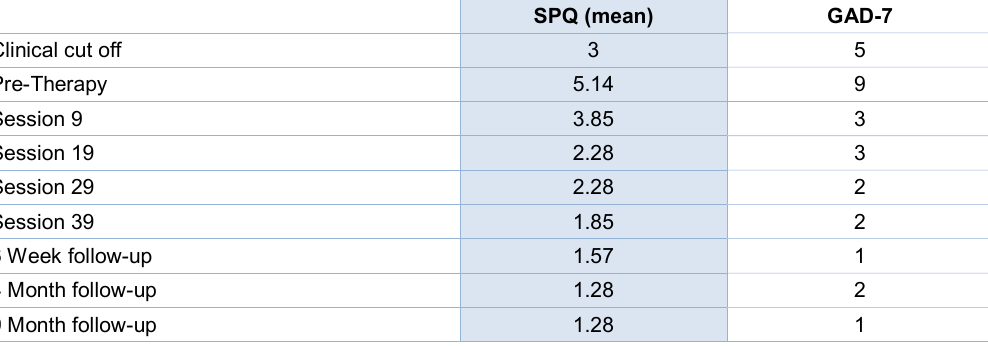
Table 2: SPQ and GAD-7 Results